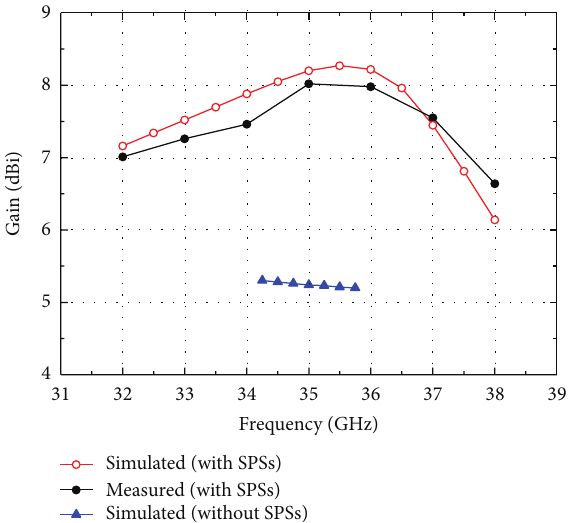
Figure 5: Simulated and measured gain of the LTCC patch antennas with and without